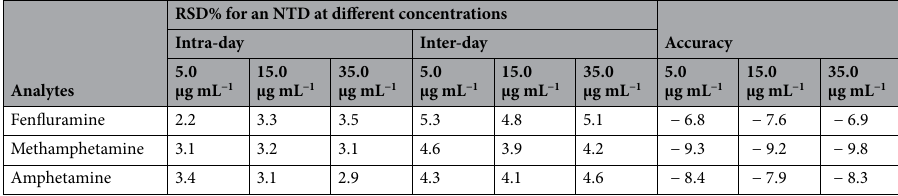
RSD% for an NTD at different